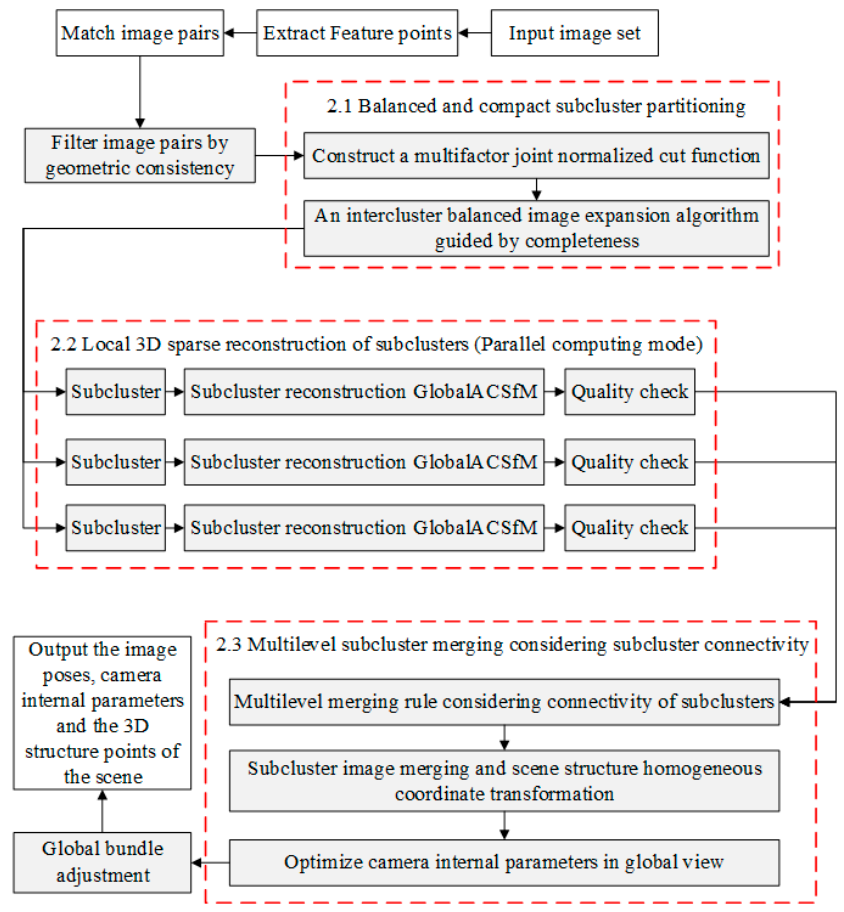
Figure 3. Flowchart of this method.